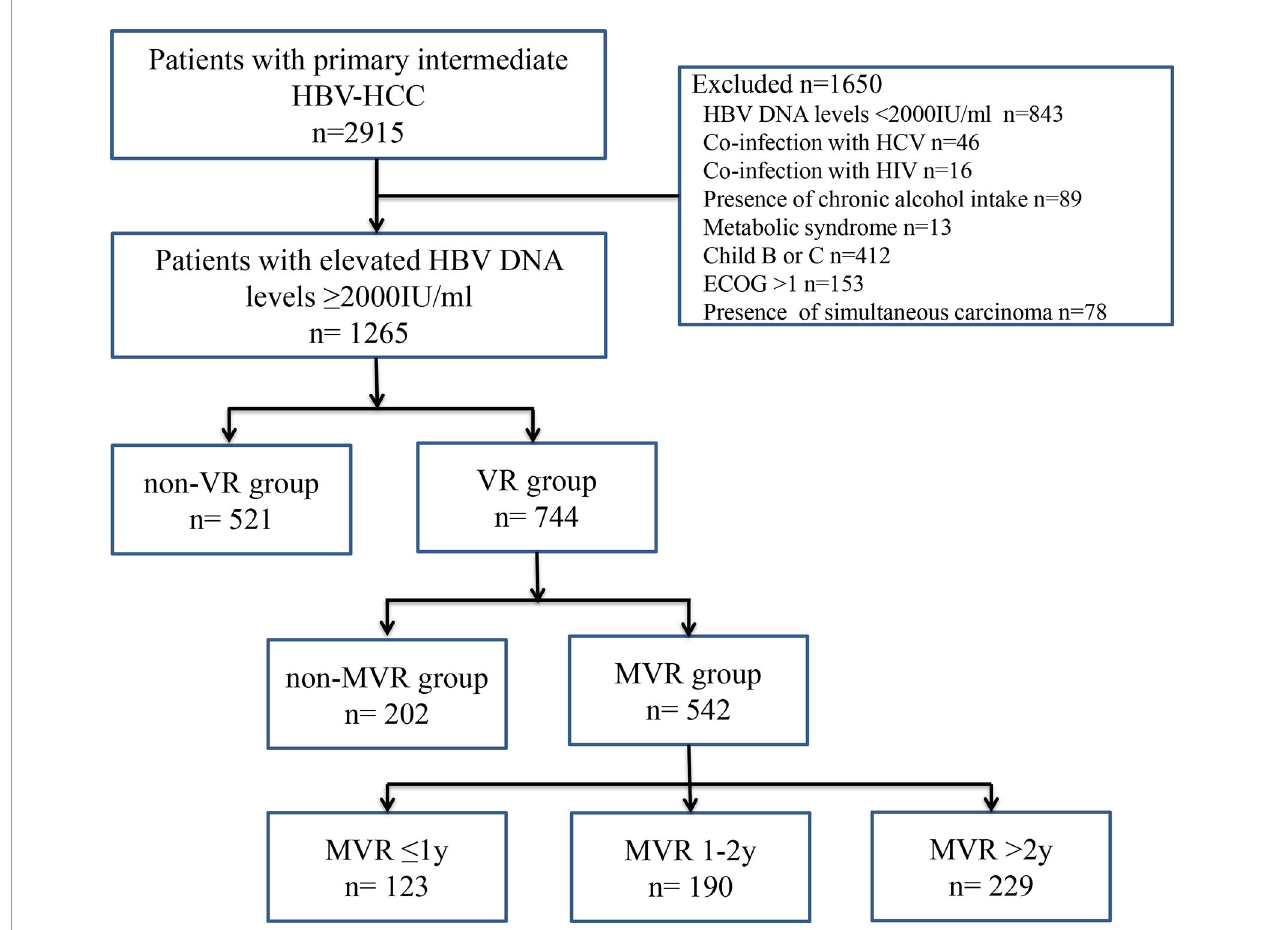
FIGURE 1 | Work fl ow chart of patient enrollment in the present study. ECOG, Eastern Cooperative Oncology Group; HBV, hepatitis B virus; HBV-HCC, hepatitis B virus-related hepatocellular carcinoma; HCV, hepatitis C virus; HIV, human immunode fi ciency virus; MVR, maintained virological response; VR, virological